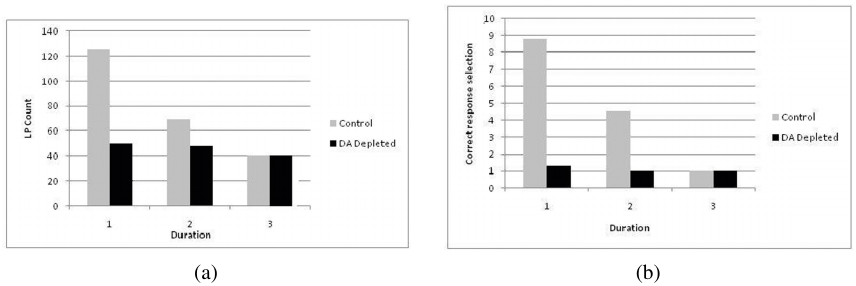
Figure 5. Changes in action frequency. (a) Behavioral results. (b) Neurocomputa- tional model